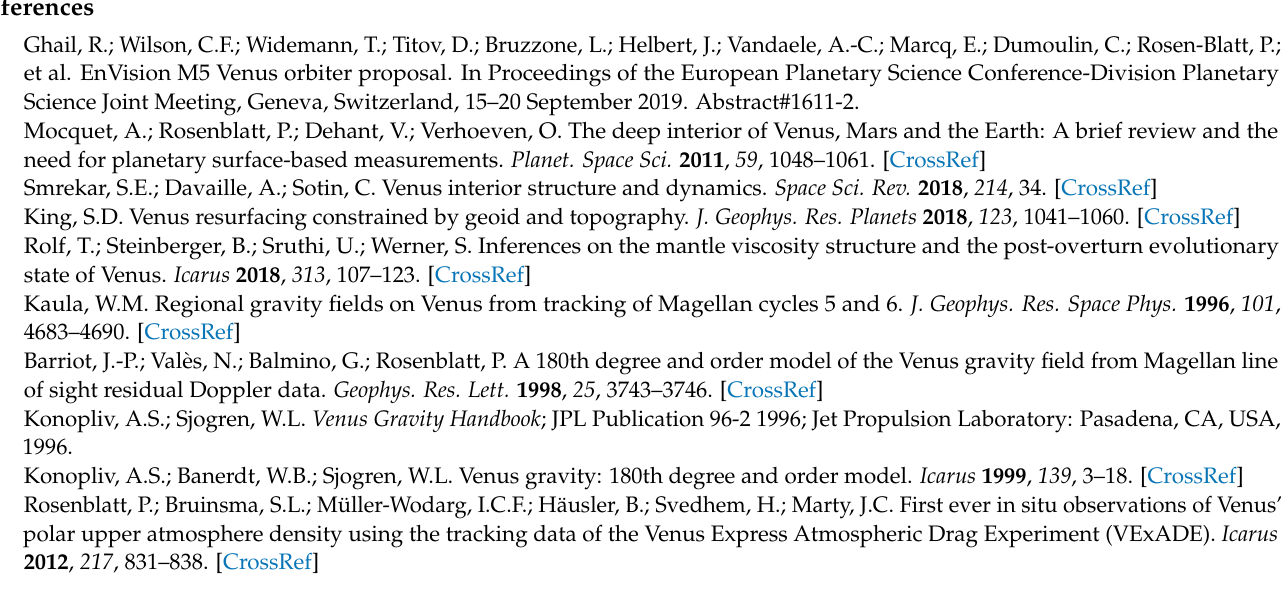
Figure A3. k 2 Love numbers computed for viscoelastic tidal deformation of Venus as a function of the tidal dissipation factor Q (adapted from Figure 4 in Dumoulin et al., 2017). The expected EnVision error of 0.1 ◦ on the tidal phase lag (Table A3) corresponds to a Q error σ Q that is represented as light-colored areas for each Q value representative of a given averaged mantle viscosity (see Table A2). The σ Q error is derived from the error on the tidal phase lag angle δ(cid:101) as follows: σ Q ≈ 2 Q 2 δ(cid:101) .